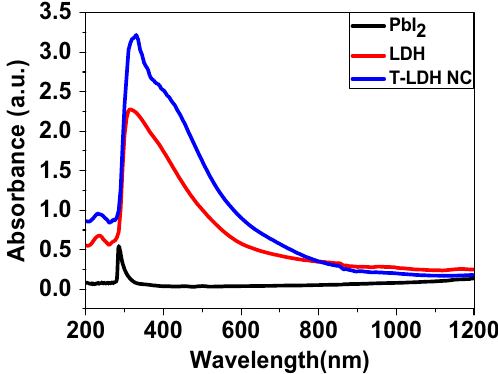
Figure 5. Absorbance spectra of PbI 2 , Co–Cd–Fe LDH, and T-LDH/PbI 2 NC.